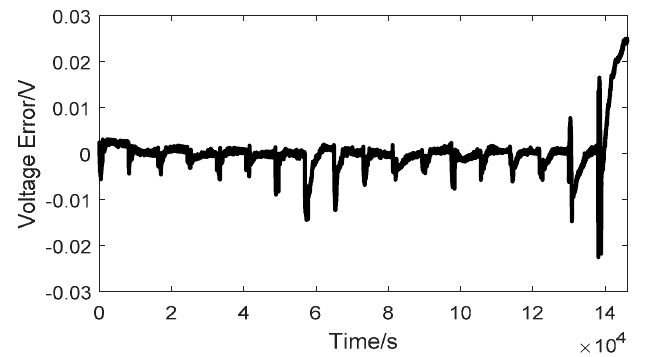
Figure 6. The voltage error of the model.